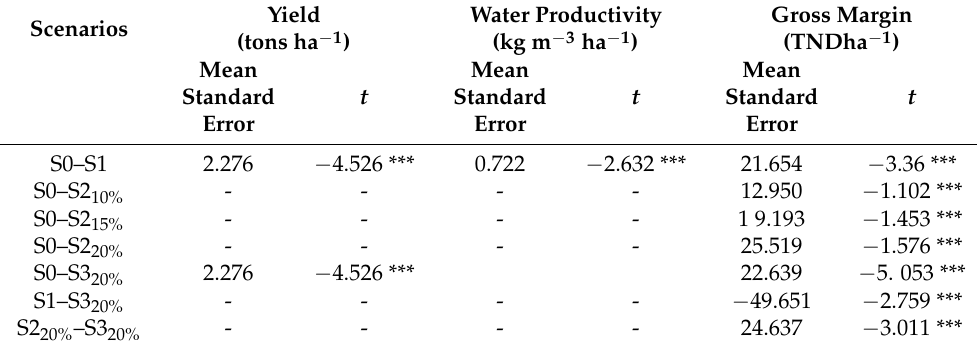
Table 6. Comparison of the means of yields, water productivity, and gross margins of DW using a Student’s t -test.